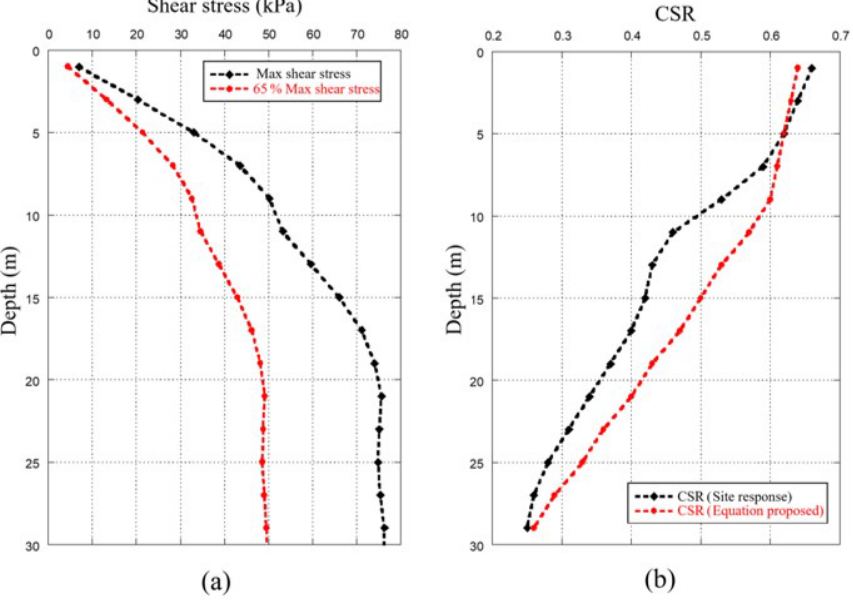
Figure 13. (a) Maximum shear stress profile for the study site and (b) cyclic stress ratio profile, using the equation proposed by Seed and Idriss (1970) and the site response